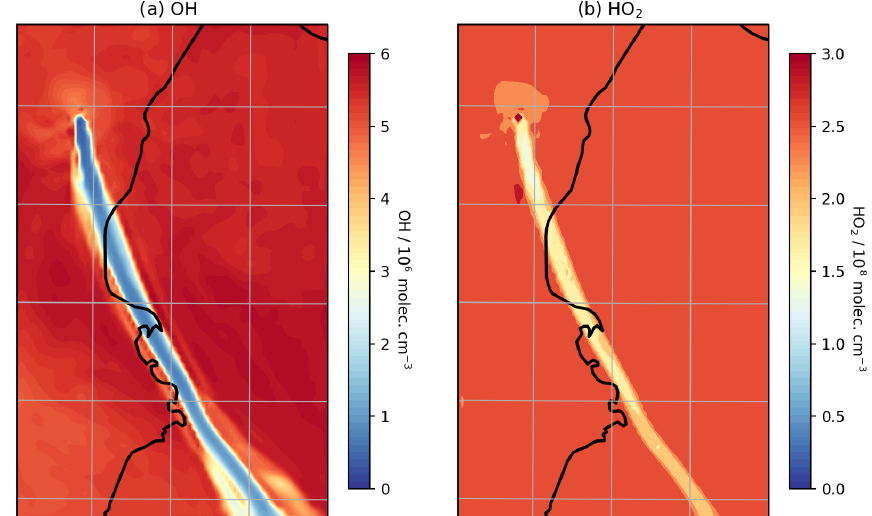
Figure 8. Modelled mixing ratios of (a) OH and (b) HO 2 at 3300ma.s.l. at 08:00UTC on 1 August 2012.